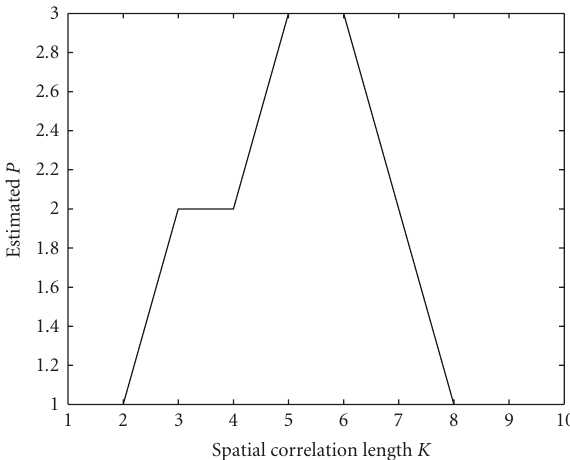
Figure 6: Estimation of the number of the sources versus K .